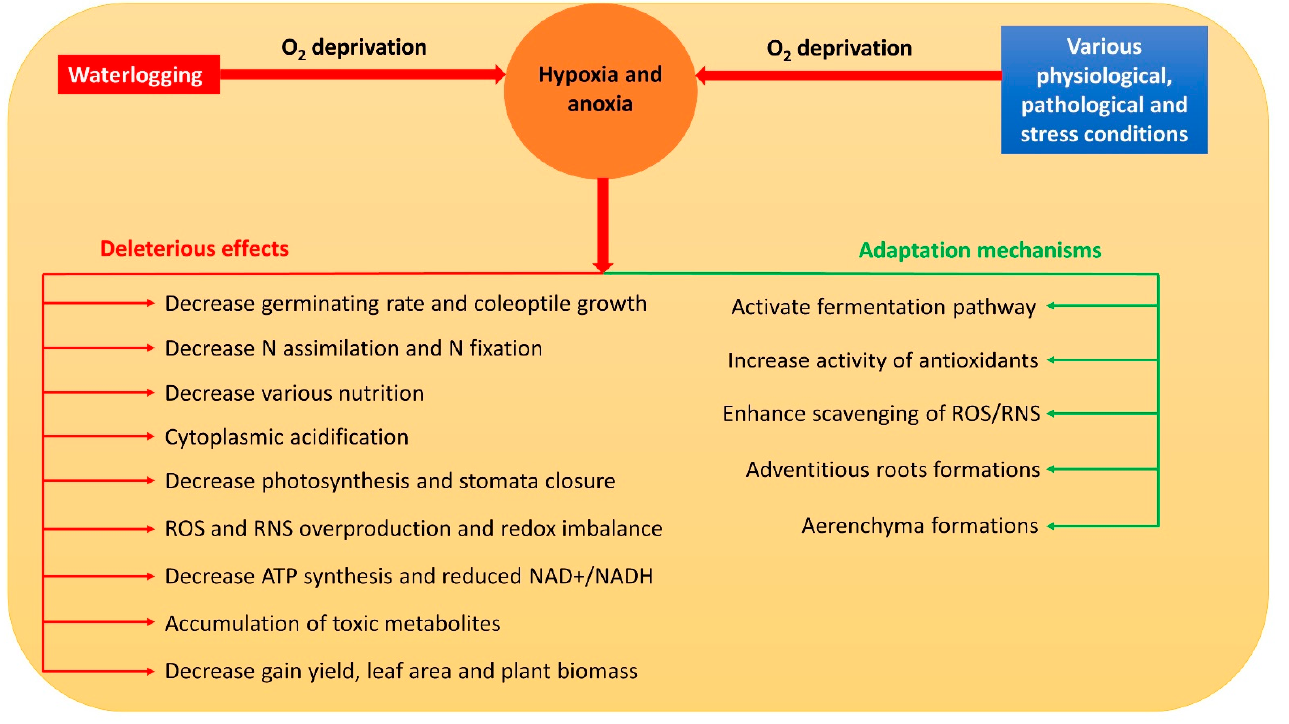
Figure 1. Possible causes of hypoxia and anoxia, their consequences, and defense mechanisms in response to O 2 deficiency. Red arrows represent negative effects to plants, while green ones represent positive effects.